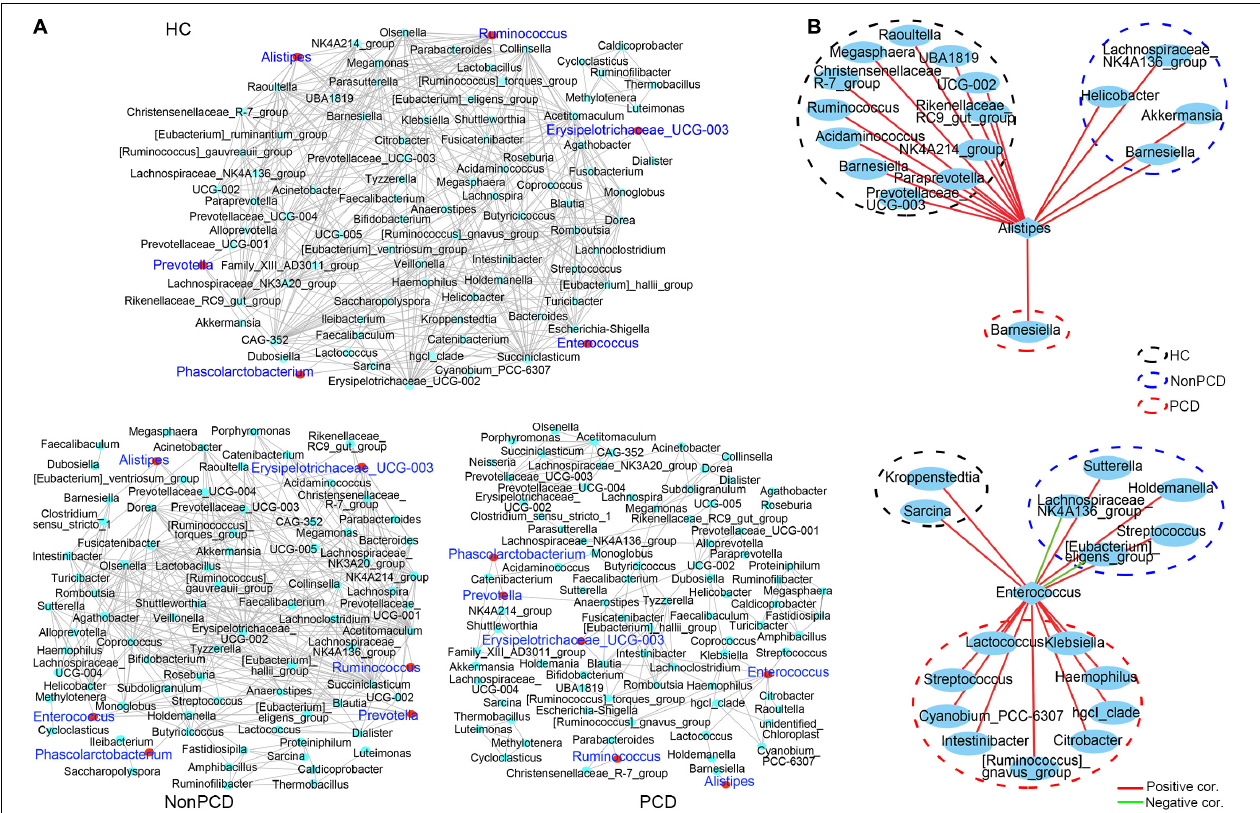
FIGURE 5 | Decreased co-occurrence network among genus bacteria in PCD patients. (A) Representative co-abundance network of genera in three groups, respectively. Based on the database of abundance of each taxon in genus, correlations among top 100 genera were calculated and correlation coefficients ( p fdr < 0.05, | r | > 0.6) were regarded as clear links and visualized by Cytoscape v3.8.2. False discovery rate (FDR) was controlled using the methods of Benjamini, Hochberg, and Yekutieli after the multiplicity testing and adjusted p fdr < 0.05 was considered significant. Green dots represent genus bacteria and the gray line between two dots represents mutual correlation; red dots were labeled blue for 6 key diarrhea-related taxa in three groups. Gut microbiota in HC and Non-PCD groups are closely connected, but tended to assemble to several modules separately in PCD. (B) Reduced co-abundance network of Alistipes (upper panel) and augmented co-abundance network of Enterococcus (lower panel) with other genus microbes in PCD. Blue circles represent bacteria in genus, red lines denote positive correlations, and green lines indicate negative correlations.